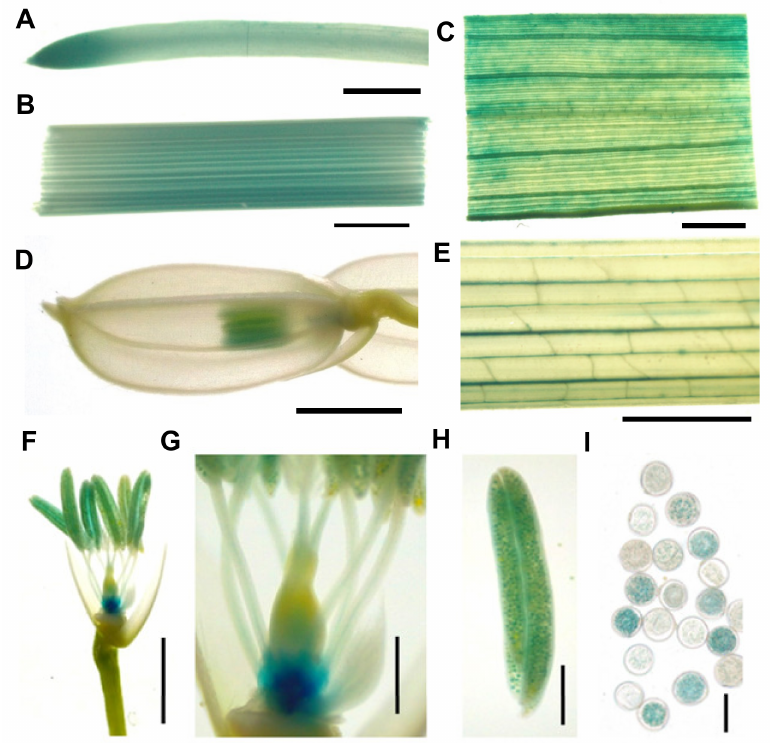
Figure 12. Expression pattern revealed by GUS staining; 2523 bp promoter sequence of LPS1 was ligated into the binary vector pCAMBIA1391Z upstream of the GUS reporter gene. ( A ) Root. ( B ) Stem. ( C ) Leaf blade. ( D ) Young panicle. ( E ) Leaf sheath. ( F ) Pistils and stamens. ( G ) Ovary, filament and style. ( H ) Anther. ( I ) Pollens. ( A–F ): Bar = 2 mm; ( G–H ): Bar = 0.5 mm.; ( I ): Bar = 50 µ